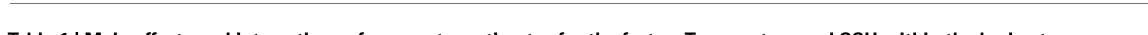
Table 1 | Main effects and interactions of parameter estimates for the factorsTemperature and SSH within the brain stem. Talairach x , y ,